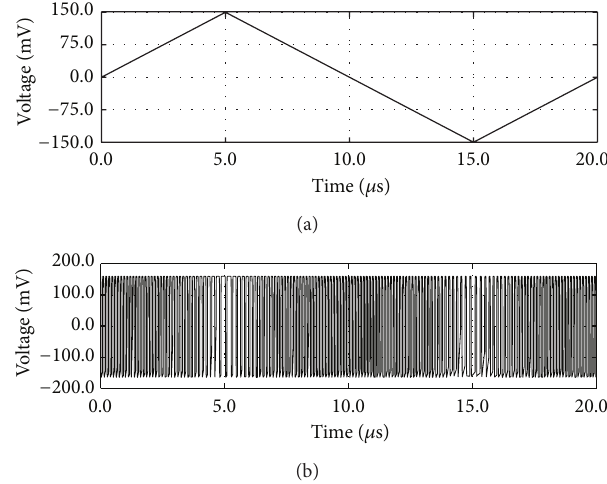
Figure 20: (a) Triangular modulating signal and (b) delta modu- lated signal.